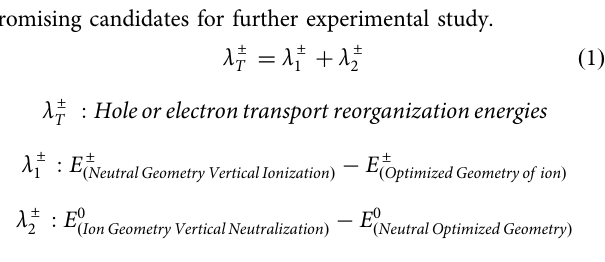
Energies are expressed in electron volts (eV). Values in parenthesis correspond to experimentally determined reorganization energies. All calculations were performed at the B3LYP/LANL2DZ level.